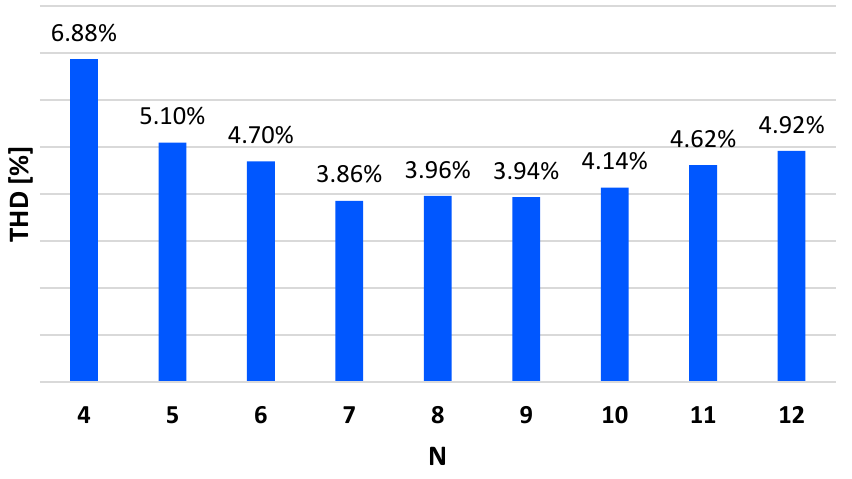
Figure 16. Phase a stator current harmonic analysis, in 3L-NPC converter for each possible N